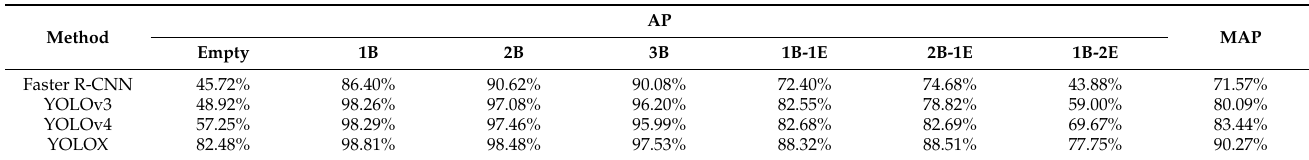
Table 8. Average accuracy versus average accuracy of pod category detection for different models in the test dataset